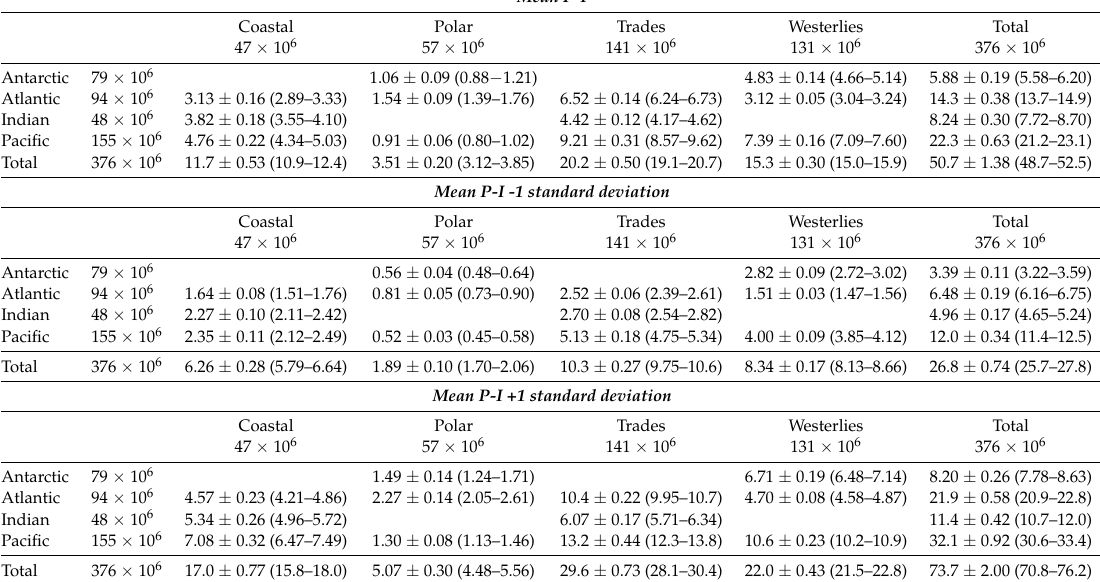
Table 2. Climatological mean and standard deviation ( n = 21) of annual primary production (in Gt C y − 1 ) between 1998 and 2018 for each ocean basin and biome as defined by Longhurst (2007). Range in annual primary production between 1998 and 2018 is given in parentheses. Results are given for primary production estimates based on mean, 1 standard deviation and +1 standard deviation − photosynthesis versus irradiance (P-I) parameters. Surface areas (in km 2 ) for each ocean basin and biome are also